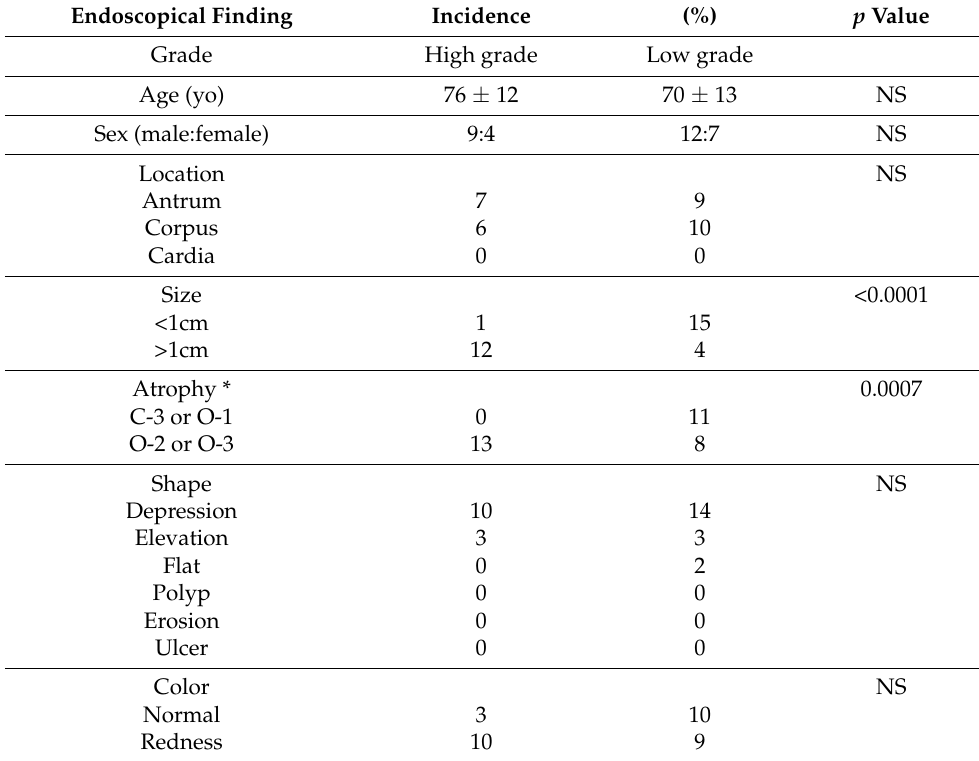
Figure 6. Endoscopic appearance of DM. ( A ) Case 9 in Table 3. High-grade DM. Male, 75 years old. Antrum, greater curvature. Lesion: 1.2 cm-sized depression with inflammation. ( B ) Case 3 in Table 3. Low-grade DM. Male, 72 years old. Lower corpus, greater curvature. Lesion: 0.8 cm-sized shallow depression with inflammation. Arrow, DM lesion. DM, dysplastic metaplasia. Table 4. Endoscopic analyses of DM.